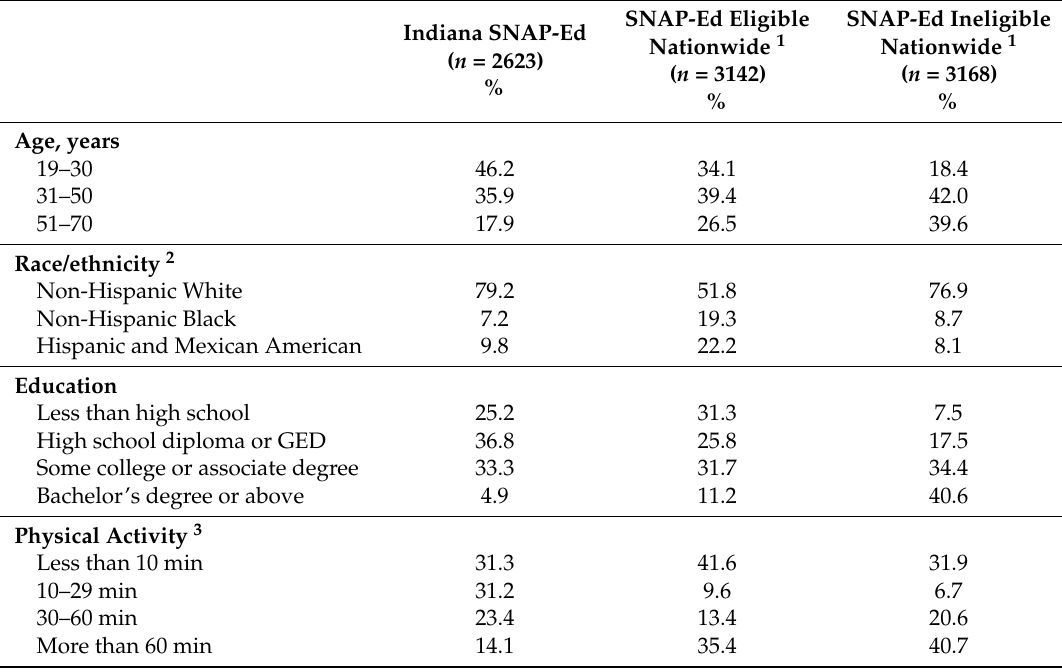
Table 1. Demographic and lifestyle characteristics of SNAP-Ed participating women in Indiana and SNAP-Ed eligible and ineligible women nationwide,